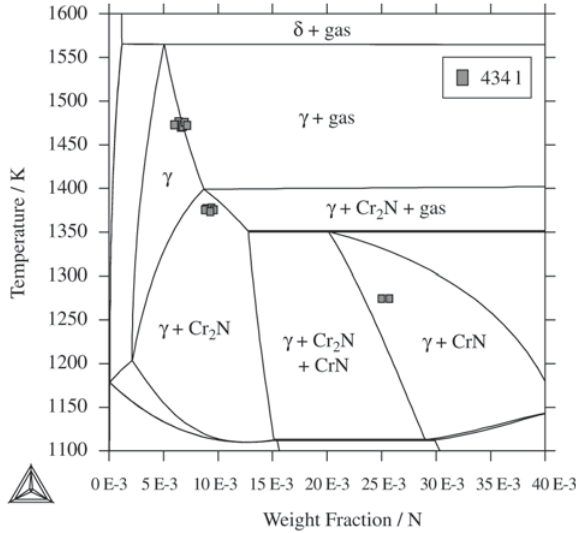
Figure 5. Isopleth of the Fe-16.2% Cr-N phase diagram and 0.15 MPa N pressure. The nitrogen contents of the samples are 2 shown as small squares.